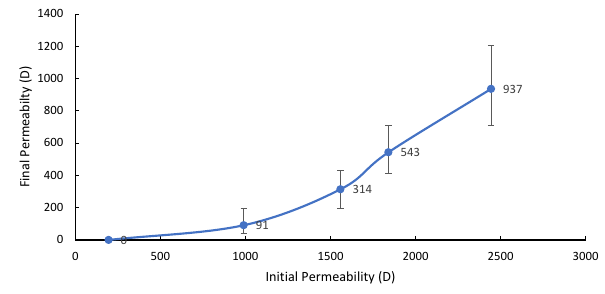
Fig. 7 Final permeability following the application of polymer